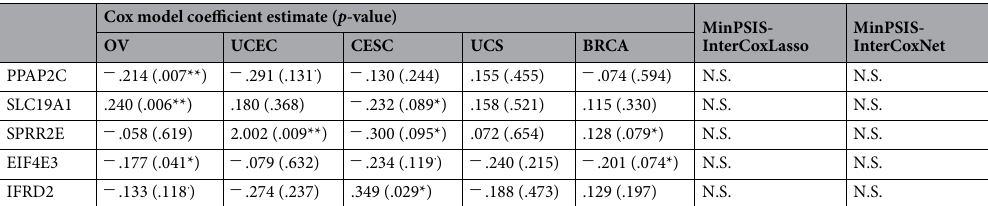
Table 3. List of the top five genes from the 29 genes selected by Cox-TOTEM with the largest absolute coefficient estimates and their corresponding coefficient estimates and p -values (in parentheses) when fitting a Cox model in each cancer type. None of those genes were selected by MinPSIS-InterCoxLasso or MinPSIS- · InterCoxNet Significant code: < 0.01 **, < 0.1 *, < 0.15 ; N.S.: not